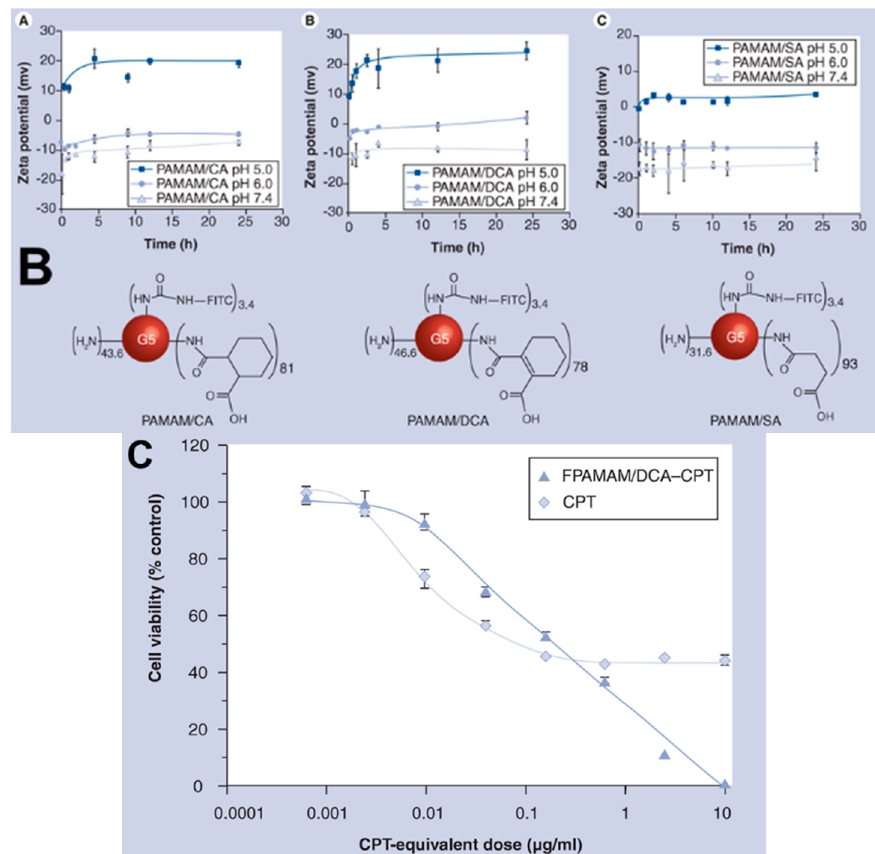
Figure 2. Charge-reversal polyamidoamine NPs for cascade nuclear delivery: ( A ) scheme of charge-reversal mediated intracellular drug delivery; ( B ) the acid-trigged charge reversal from negative to positive; and ( C ) the cytotoxicity against SKOV-3 ovarian cancer cells for 24 h treatment. Note: Folic receptor-targeting charge-reversal PAMAM–CPT conjugate (FPAMAM/amide–CPT); Trans-1,2-cyclohexanedicarboxylic anhydride(CA); 1,2-dicarboxylic-cyclohexene anhydride(DCA); Succinic anhydride(SA). Reproduced with permission from Shen et al. (2010). Copyright 2010 Future Medicine.